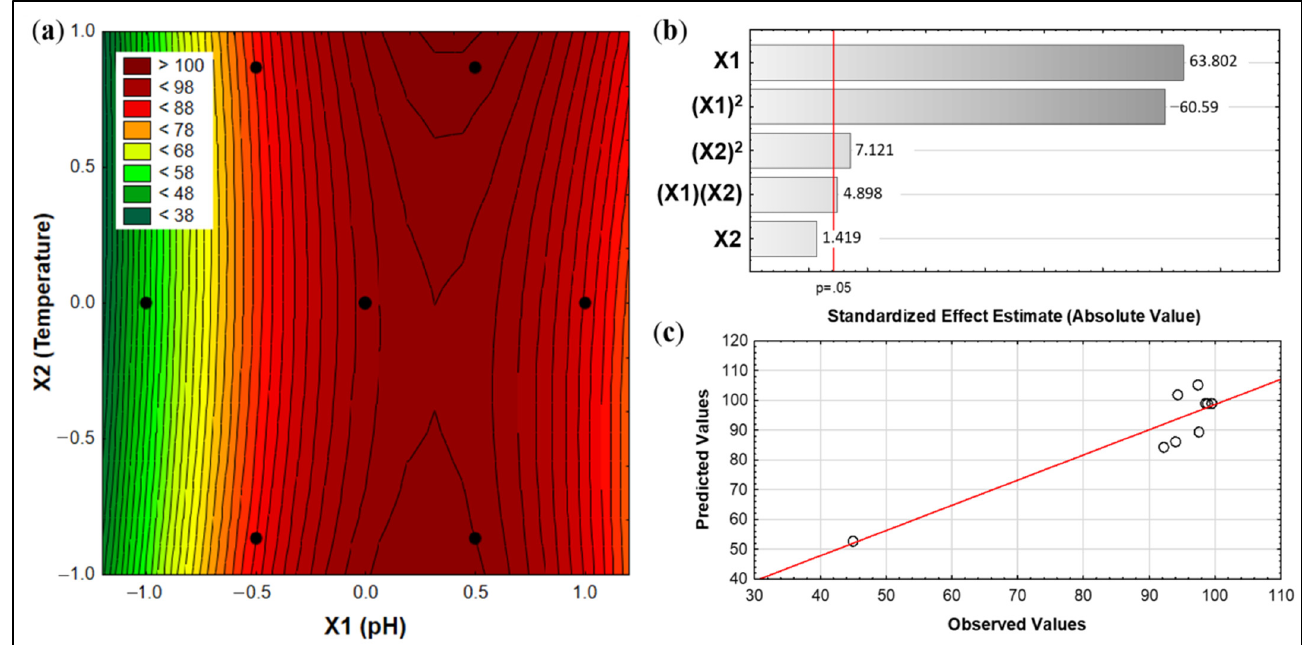
Figure 10. Response surface for the percent adsorption removal of MB by SAP-AC after 24 h of continuous recirculation. ( a ) Contour plot of adsorption as a function of pH and temperature; ( b ) Pareto chart of standardized effect estimates; and ( c ) residual plot showing observed vs. predicted values. ( C MB,0 = 50 ppm; V = 300 mL; m SAP-AC,0 = 70 mg.).